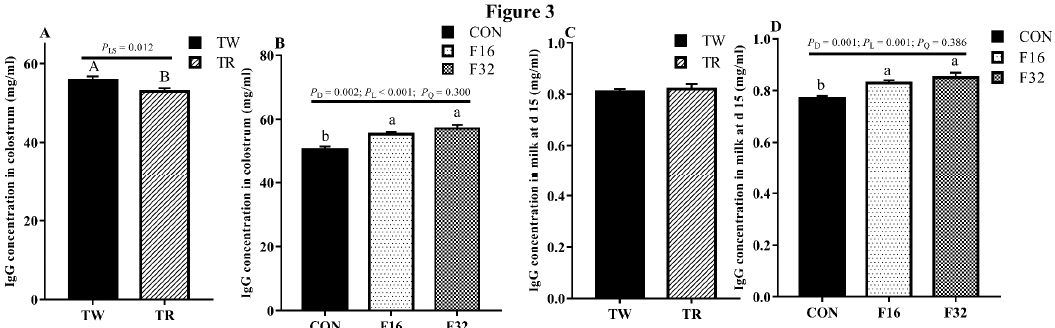
Figure 3. IgG concentrations a ff ected by litter size ( A , C ) and dietary FA levels ( B , D ) in milk. Data are means ± SEM. TW, twin born; TR, triplet born; CON, F16 and F32, ewes fed 0, 16, or 32 mg · (kg.DM) − 1 FA in the basal diet, respectively. P LS , P value of litter size; P D , P value of diet FA supplementation; P L , P value of liner e ff ect; P Q , P value of quadratic e ff